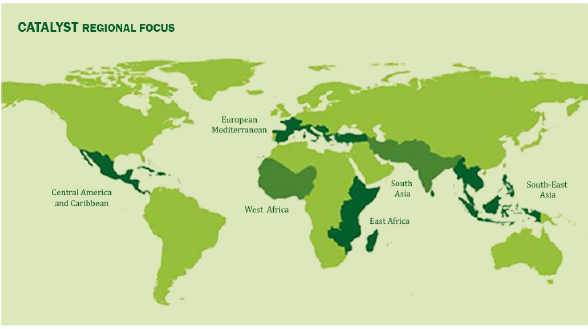
Figure 1. The CATALYST regions (Jaspers et al.,